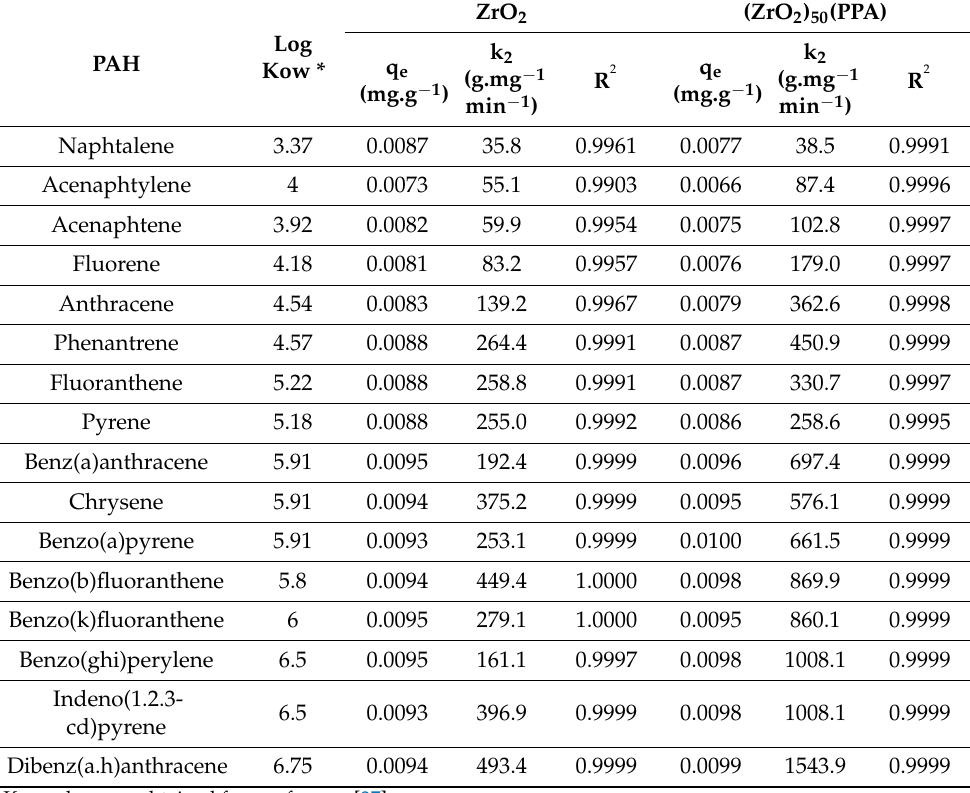
Table A2. (g.mg − 1 .min − 1 ), and fit accuracy using a Pseudo-second-order Kinetic Plots for the Adsorption